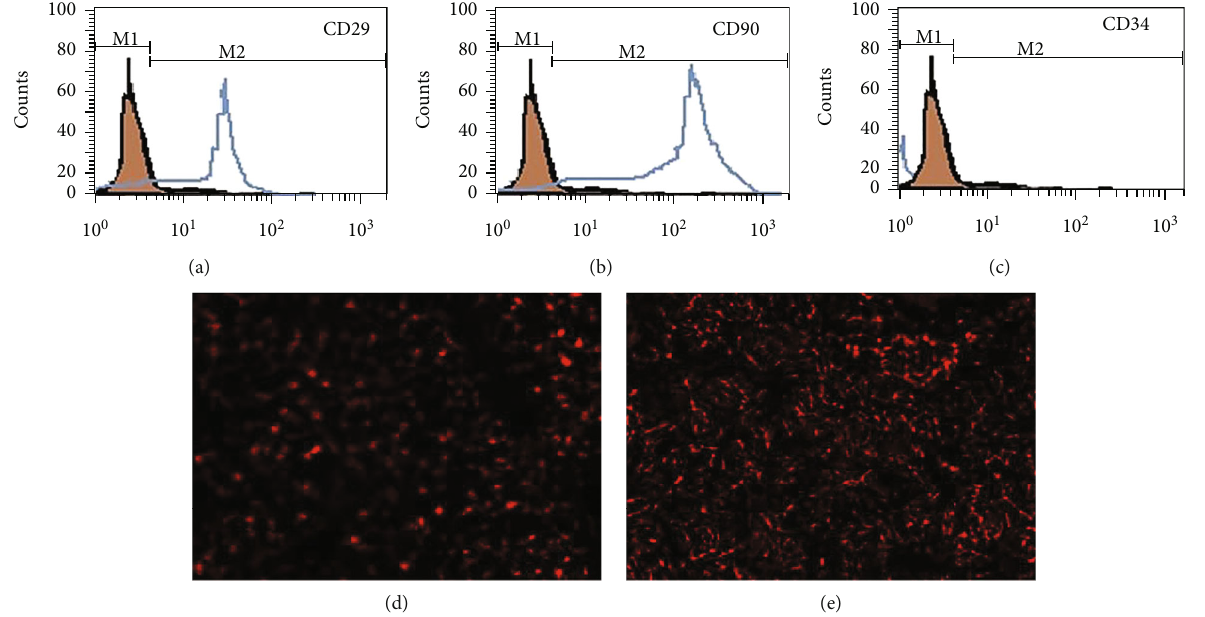
Figure 2: Characteristics and identi fi cation of AD-MSCs. The MSCs were identi fi ed by their immunological phenotypes; the isolated and cultured cells were positive for CD29 (a) and CD90 (b) and were negative for CD34 (c). Muscle (d) and adipose tissue (e) sections were investigated by fl uorescence microscope which revealed homing of AD-MSCs labeled with PKH26 fl uorescent dye (red fl uorescence). Table 1: Levels of fasting glucose, insulin, and HOMA-IR after induction of diabetes and before treatment. Variables Control group T2DM group AD-MSCs group AD-MSCs pretreated with OXA group Fasting glucose (mmol/l)